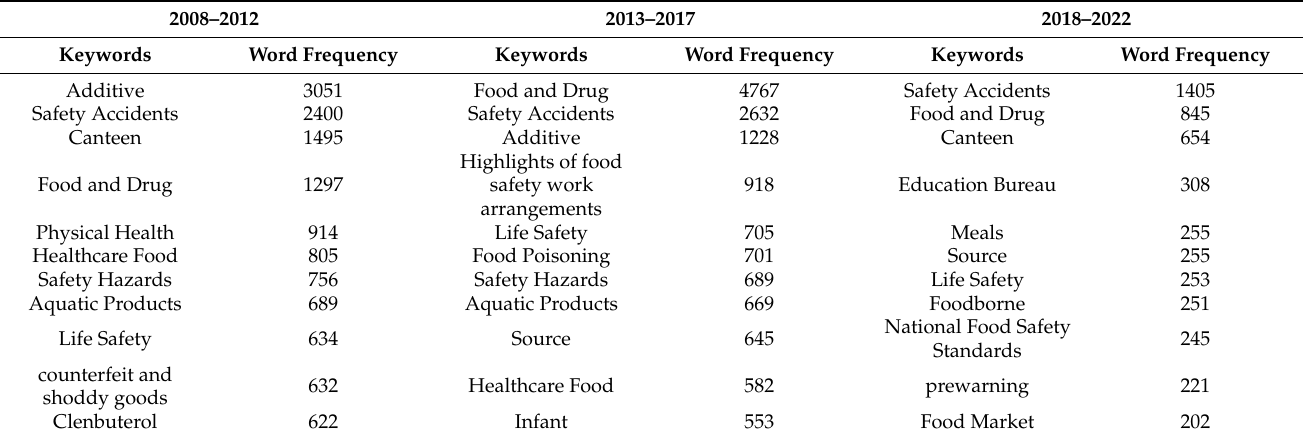
Table 2. Annual keywords of local food safety